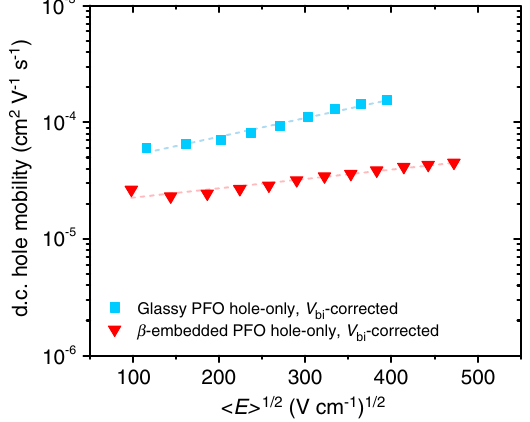
FIG. 4. Steady-state μ estimated from frequency-dependent h impedance spectroscopy, as explained in Appendix C, Part 4 and Appendix G, Part 1, for hole injection through the Au = MoO of x the same devices used for steady-state J − V measurements. The μ values are plotted as a function of the square root of the applied h electric field. Hole mobilities were obtained by correcting for a built-in potential of about 0.47 Vestimated from the capacitance – voltage ( C − V ) response of the β -phase embedded device, and by using a dispersion factor of 0.5 (see Appendix C, Part 4 for details). The arithmetic means of electric field are calculated by deducting this built-in potential and averaging the effective applied bias across the layer thickness [see Appendix G, Part 2 for the estimation of V using C − V measurements on the bi hole-only devices, and Fig. 12(d) for a simulated set of electro- static profiles across the active layers of the hole-only